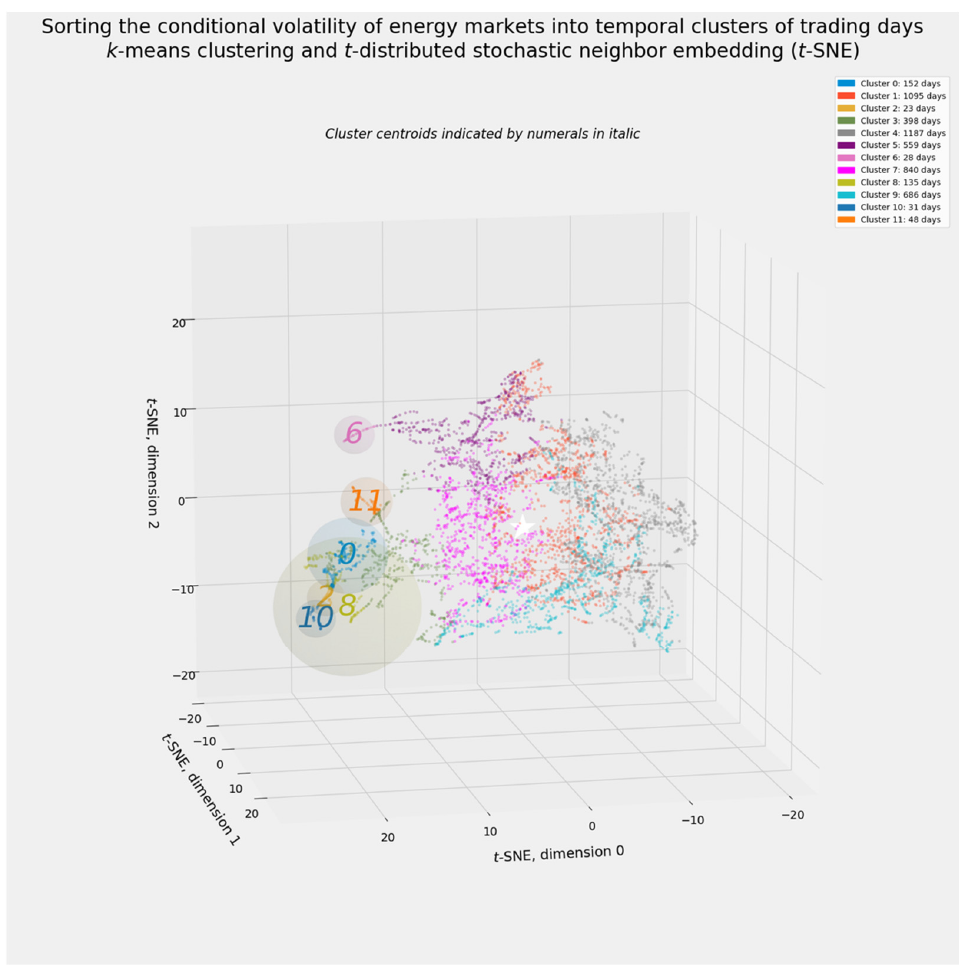
Figure 35. k -means clustering of energy-related markets—A t -SNE manifold, with clusters of interest indicated by their synthetic centroids.